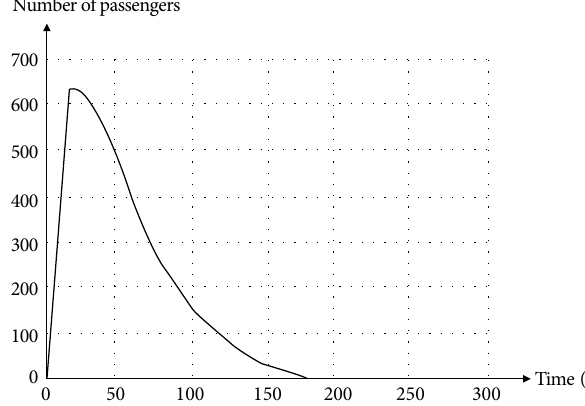
Figure 3: Relationship between passengers on B5 floor and